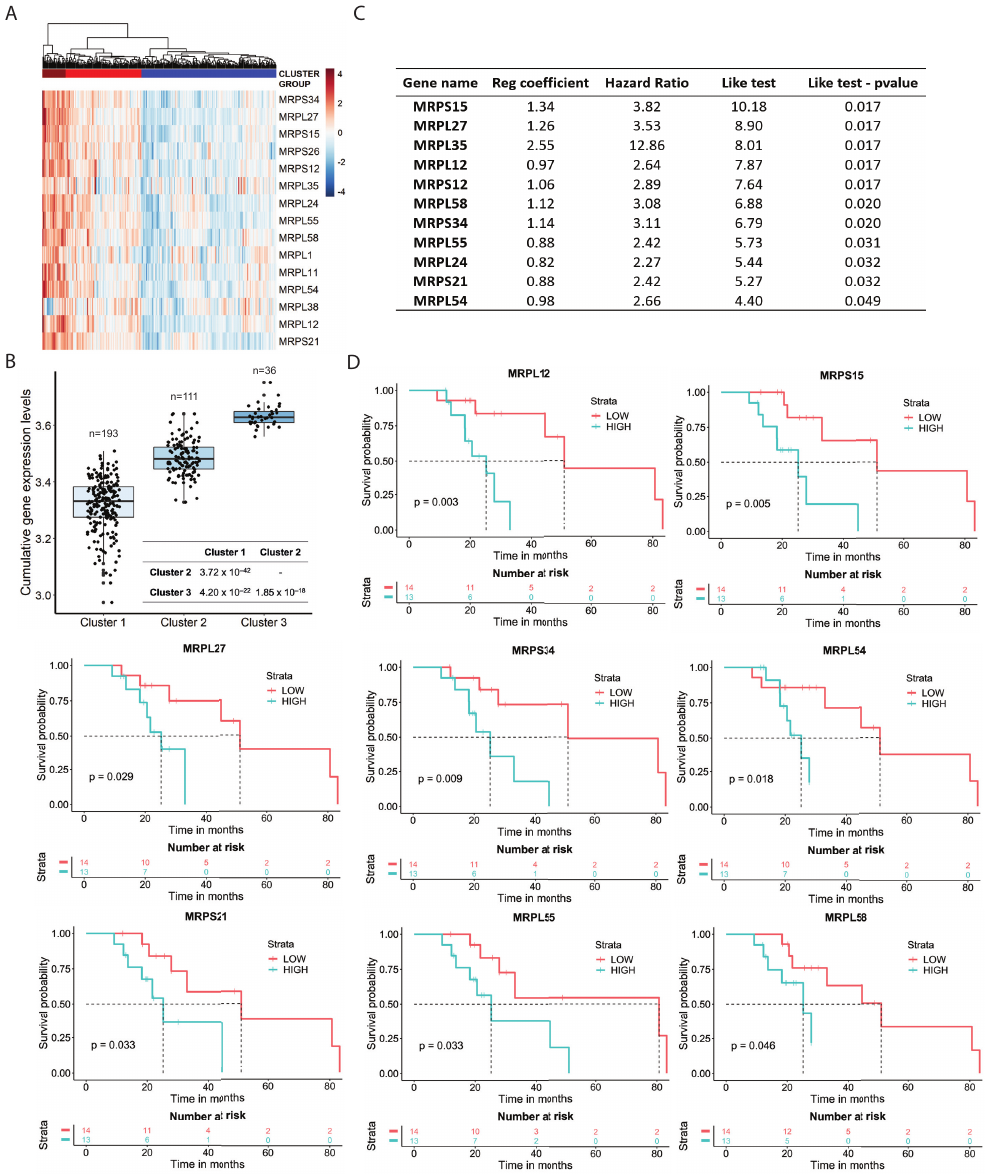
Figure 2. Expression of mitochondrial ribosomal proteins and response to sorafenib in hepatocarcinoma patients. ( A ) Un–supervised clustering of HCC samples in the TCGA patient cohort based on the expression of the sorafenib upregulated mitochondrial ribosomal protein (MRP) gene set. Total number of patients examined was 340. Number of patients in each cluster is reported in B. ( B ) Cumulative expression of MRP gene set in the distinct clusters of HCC samples. Bottom, p -values for inter − cluster comparisons. ( C ) Association of individual MRP gene expression and overall survival by Cox proportional hazard regression analysis. ( D ) Kaplan–Meyer survival analysis of overall survival based on the median expression of individual MRP genes in subset of patients receiving sorafenib in the TCGA